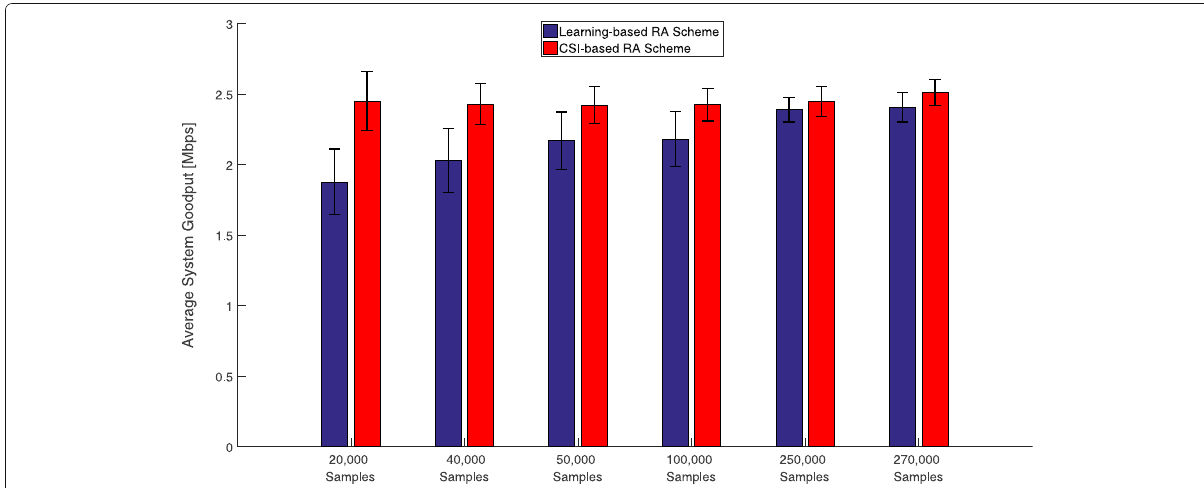
Fig. 8 Performance evaluation for varying number of training and test samples for the proposed learning-based RA and CSI-based RA